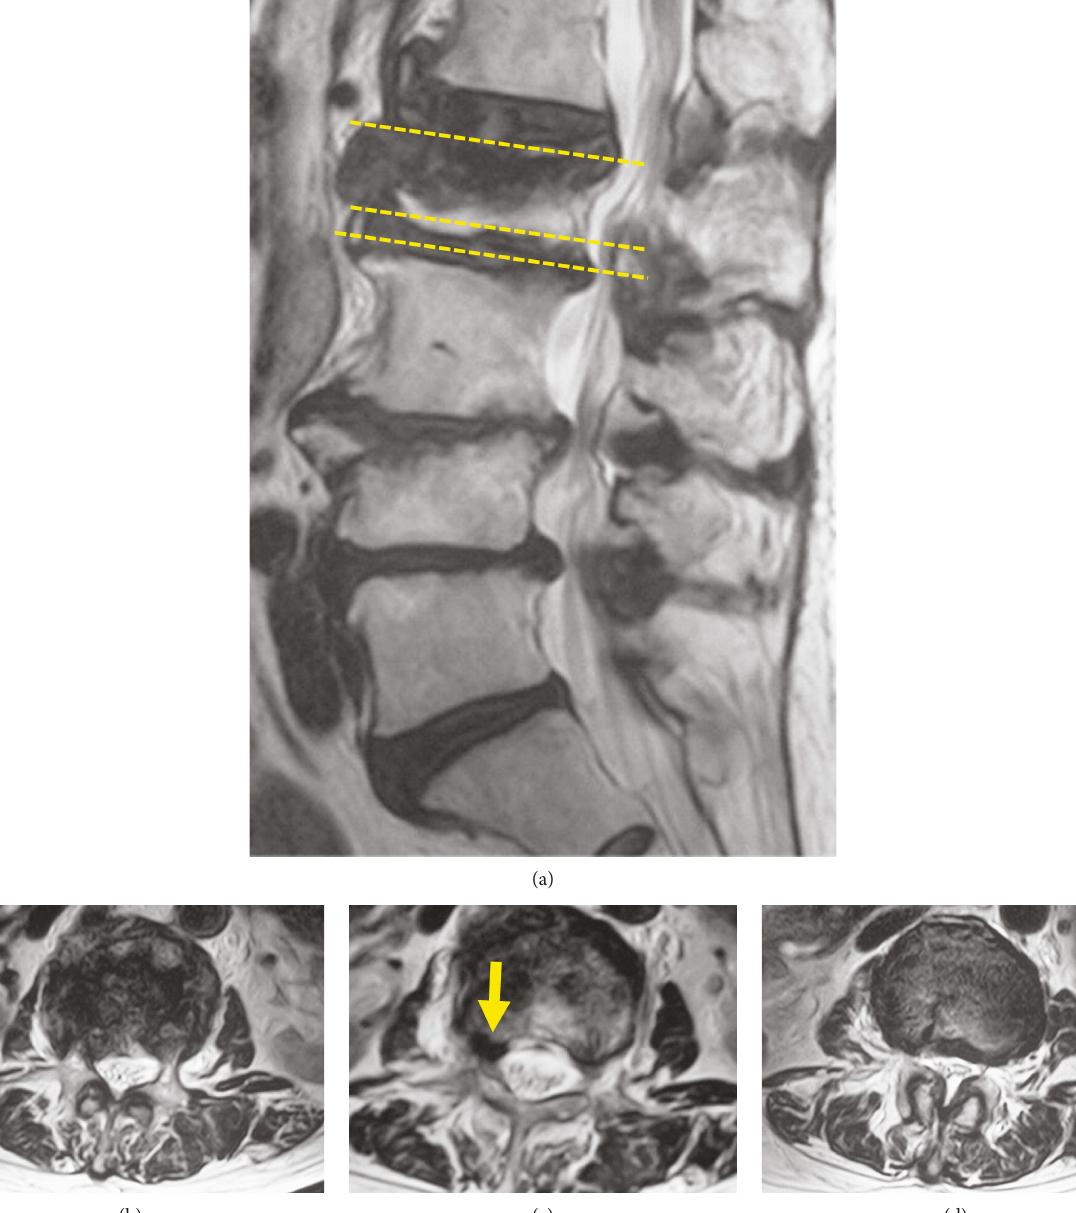
Figure 1: (a) Preoperative sagittal MR image showing low intensity zone in upper L2 vertebral body. (b), (c), and (d): mild canal stenosis at the L2 level and moderate stenosis at the L2/3 level. There was a mass in the rt L2/3 foramen (arrow in